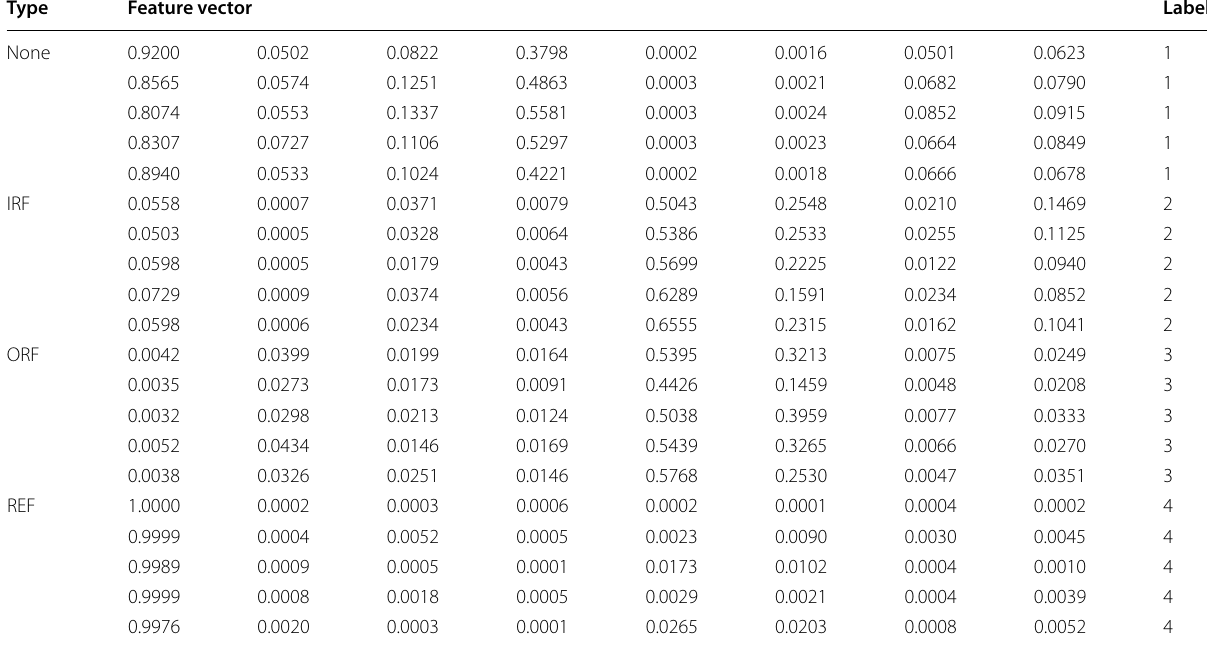
Table 1 Feature data of bearing with a fault diameter of 0.021 inches